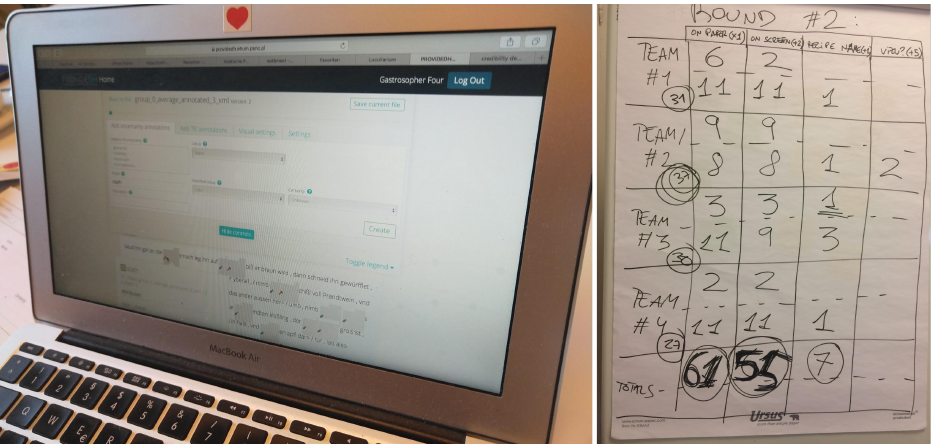
Figure 3. ( Left ) Annotation prototype shown running on the laptop of one of the participants. The prototype, that was used by the users under controlled conditions in the second part of the workshops, offered a simple interface to attach annotations to TEI documents employing the proposed uncertainty taxonomy. ( Right ) An example of an annotation identified as “other/unknown” in the recipe